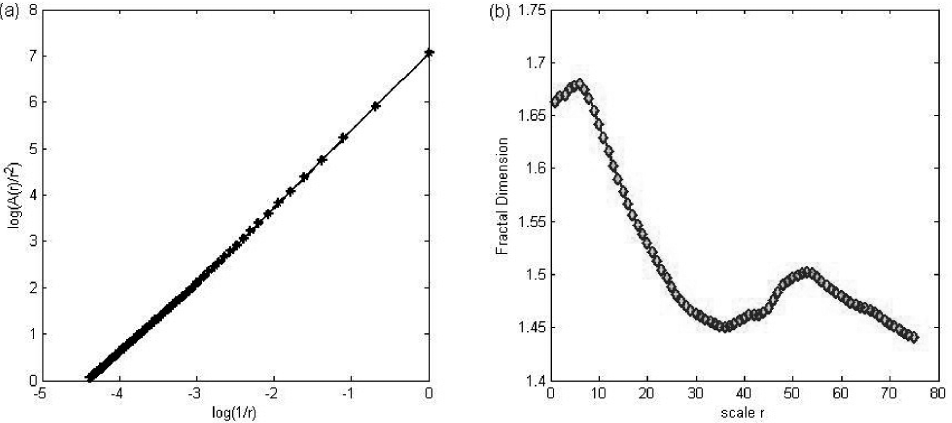
Fig. 4. (a) log-log curve of A g ( r ) /r 2 versus 1 /r ; (b) the multi-scale fractal dimensions derived of